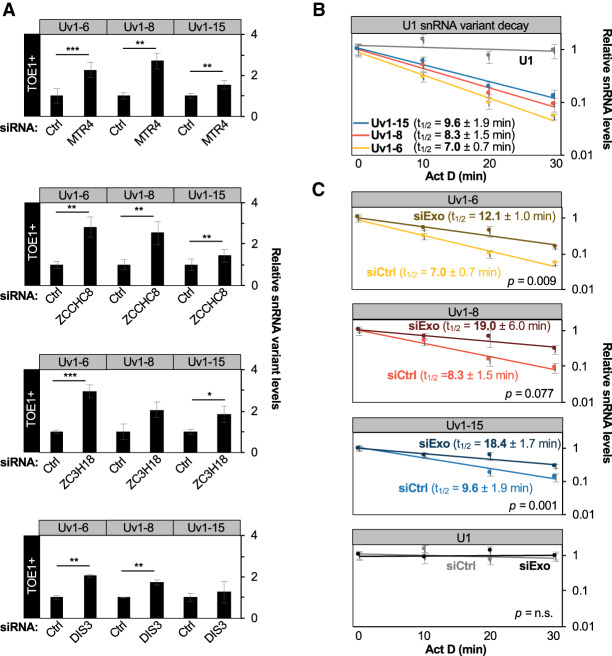
U1 variant snRNAs are targets of the nuclear exosome. (A) Relative levels of U1 variant snRNAs after siRNA-mediated depletion of MTR4, ZCCHC8, ZC3H18, and DIS3 as measured by RT-qPCR from total RNA and normalized to average values for negative control (Ctrl) Luciferase siRNA-treated samples. Averages of mitochondrial 12S and 7SK RNA levels served as internal normalization controls. (B) SnRNA turnover assays monitoring the fraction of U1 variant snRNAs remaining after actinomycin D-mediated transcription shut-off compared with the 0 time point (no actinomycin D) as measured by RT-qPCR. Shown half-lives (t1/2) were calculated after normalization of U1 variant levels to the average of 7SK and 12S RNA levels. (C) SnRNA turnover assays for U1 variant snRNAs after siRNA-mediated depletion of MTR4 and ZCCHC8 (siExo) as compared with a control siRNA (siCtrl) with normalization as in B. Error bars indicate SEM from at least three independent experiments. P-values (Student's two-tailed t-test): (*) P < 0.1; (**) P < 0.05; (***) P < 0.01. See also Supplemental Figure S6.